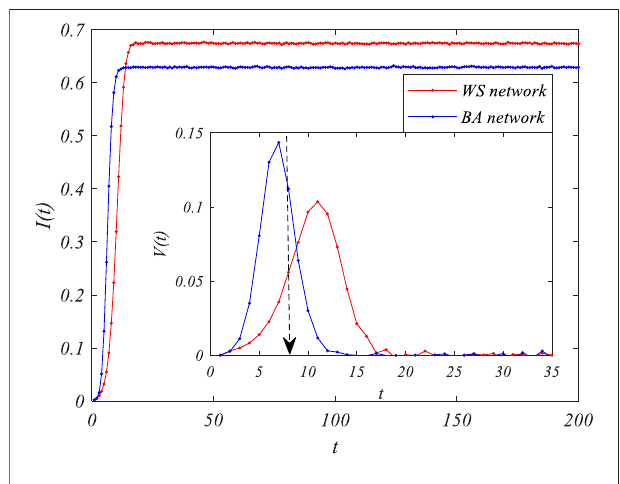
FIGURE 1 | The susceptible – infected – susceptible (SIS)